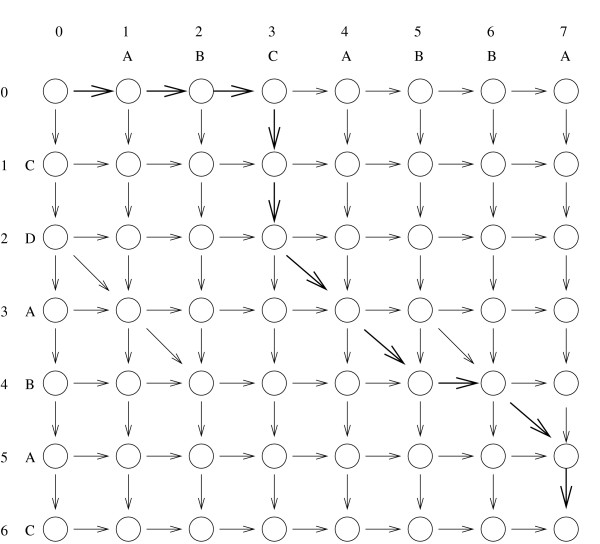
an edit graph with fragments. An LCS from Fragments edit graph for the same strings as in Figure 2, where the fragments are the sequences of at least two diagonal edges of Figure 2. The bold path from (0, 0) to (6, 7) corresponds to a minimum-cost path under the Levenshtein edit distance.